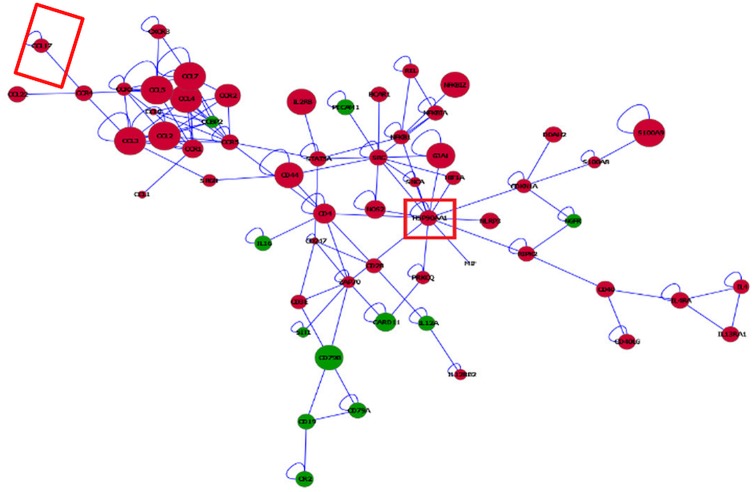
Visualization of the networks of genes differentially expressed between IDO1-knock out (IDO1-KO) and wild type (WT) mice in macrophages.Red (green) nodes indicate genes over- (under-) expressed in IDO1-KO relative to wild type. Node size indicate the P-value (large nodes indicate a more extreme nominal P-value < 0.0001 and small nodes indicate a P-value between 0.05 and 0.0001). Edges denote known relationships between genes and framed genes (red square) are discussed.